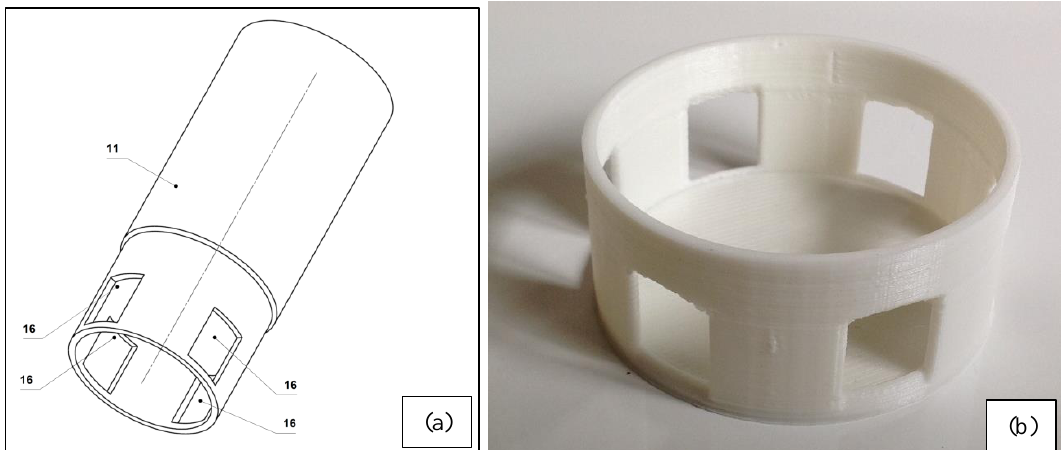
Figure 6. Schematic of the control sleeve (meshed diaphragm) with through holes: (а) and a prototype; (b) 11- movable control sleeve; 16-